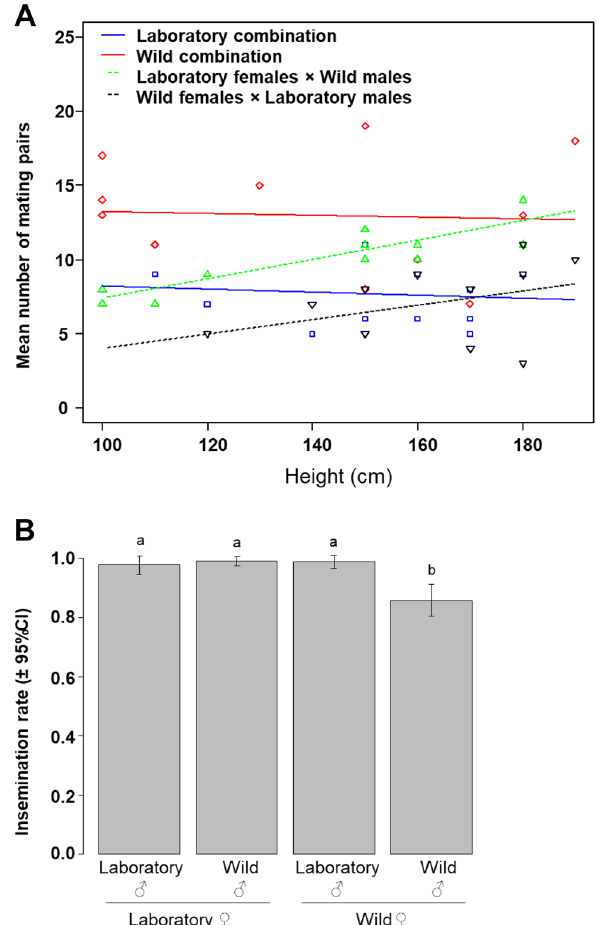
Figure 1. Effects of colonization on swarm characteristics and mating success (Experiment 1). ( A ) Mean number of mating pairs according to mating combinations and swarm height; ( B ) Mean insemination rate. CI: 95% confidence interval. SE: standard errors. Different letters above bars show statistical significance for multiple comparisons at P <